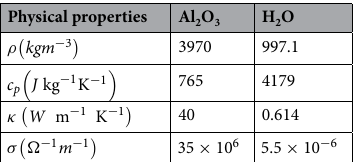
Table 2. Numerical values of the thermo-physical properties of nanoparticles and base fluid.